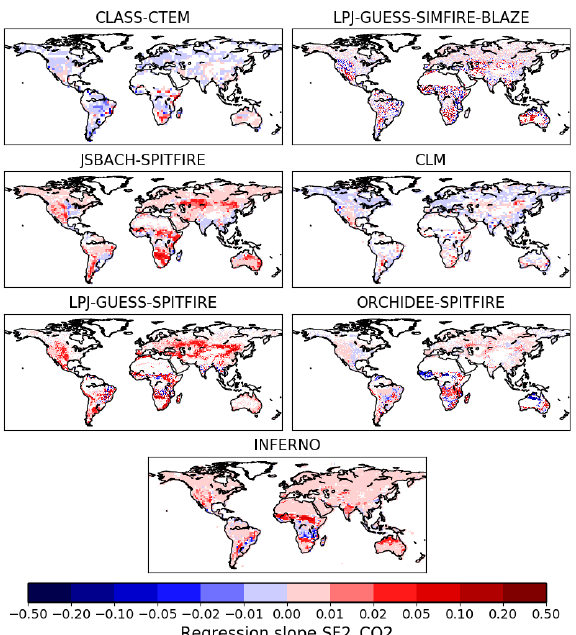
Figure A3. Spatial distribution of regression slopes for the difference between the baseline experiment SF1 and the sensitivity experiment SF2_CO2 (SF1–SF2_CO2; see Table 1) over 1921–2013.